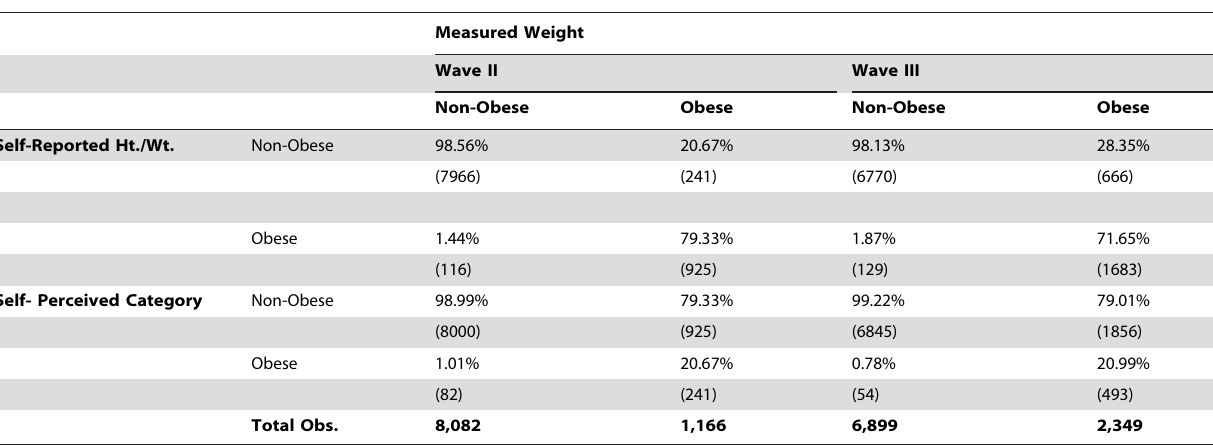
Table 2. Detailed Comparison of Measured and Self-Described Weight Categories.